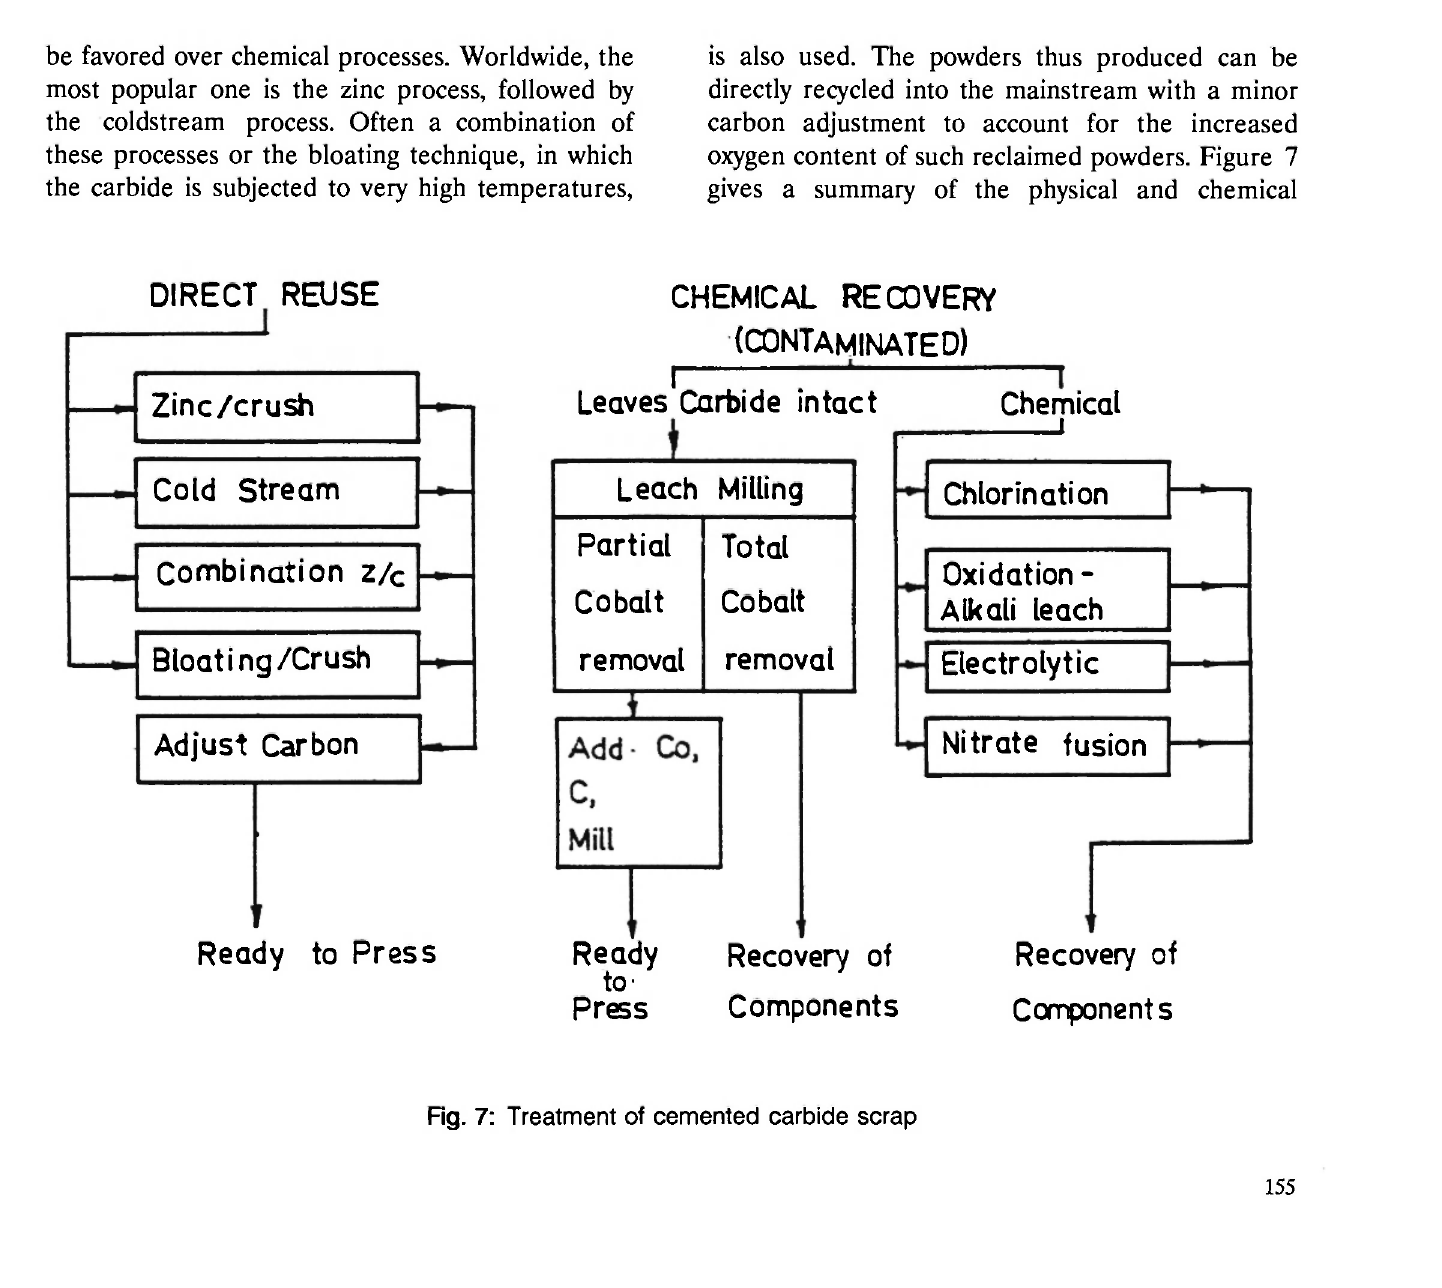
Fig. 6: Treatment of heavy metal scrap